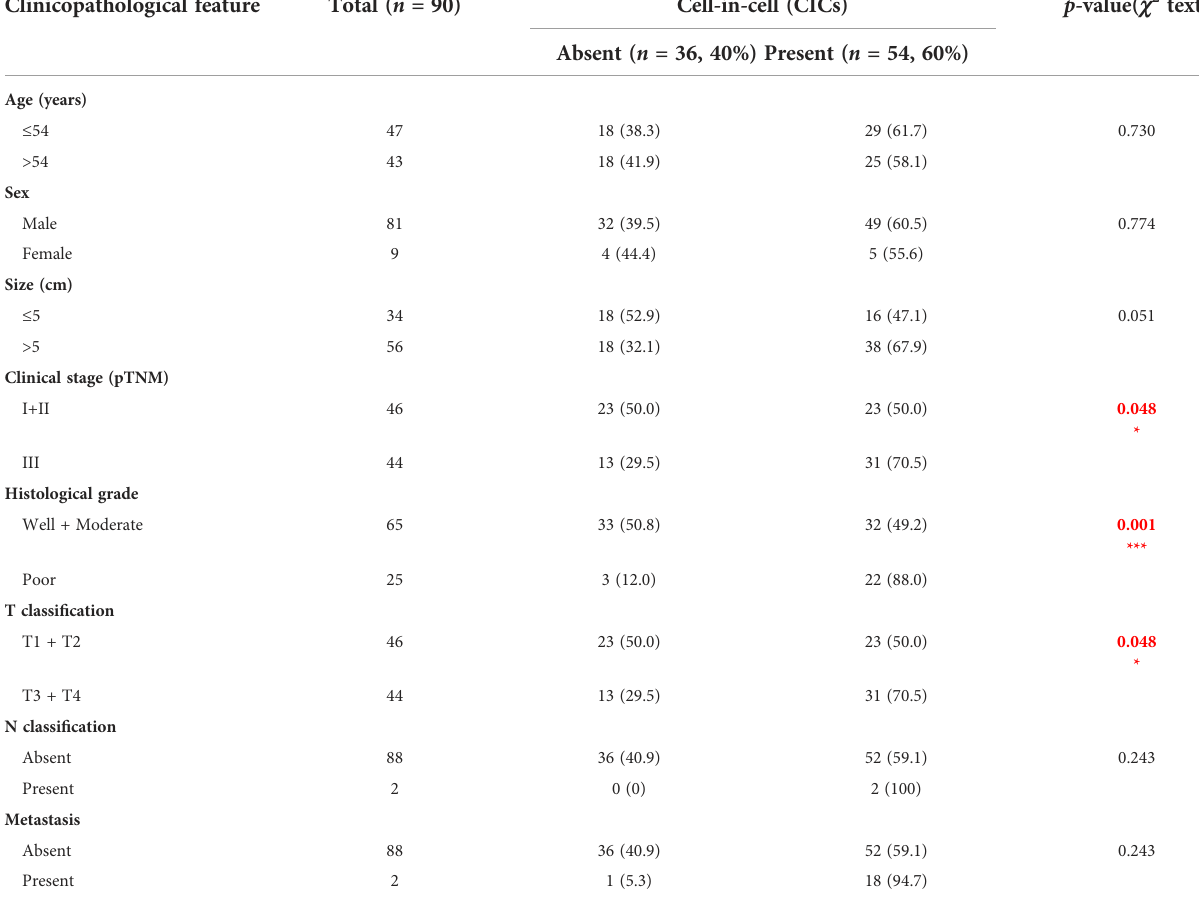
TABLE 1 Correlations between CICs and clinicopathological features in patients with hepatocellular carcinoma (HCC). Clinicopathological